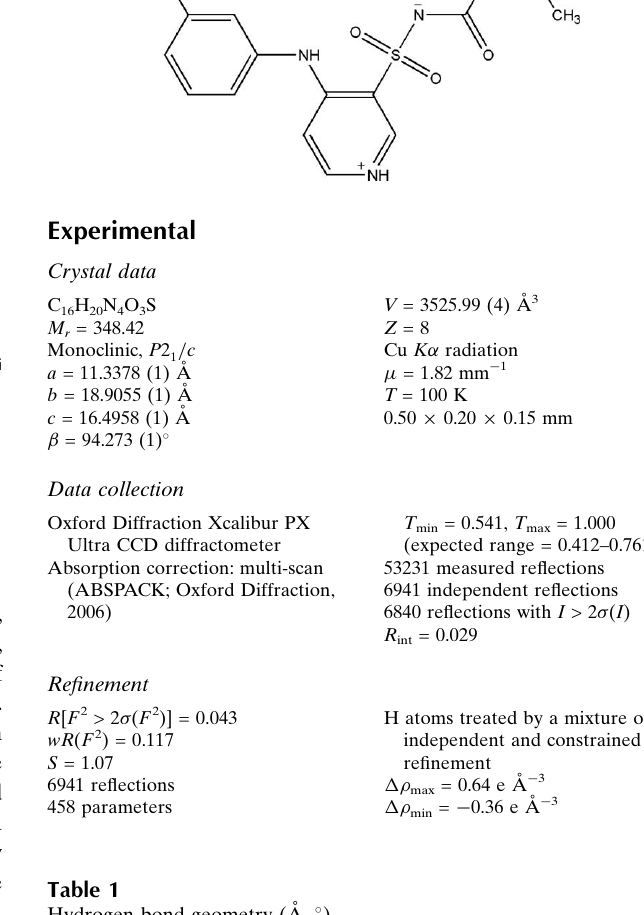
Hydrogen-bond geometry (A˚ , (cid:1) ). D —H (cid:2)(cid:2)(cid:2)